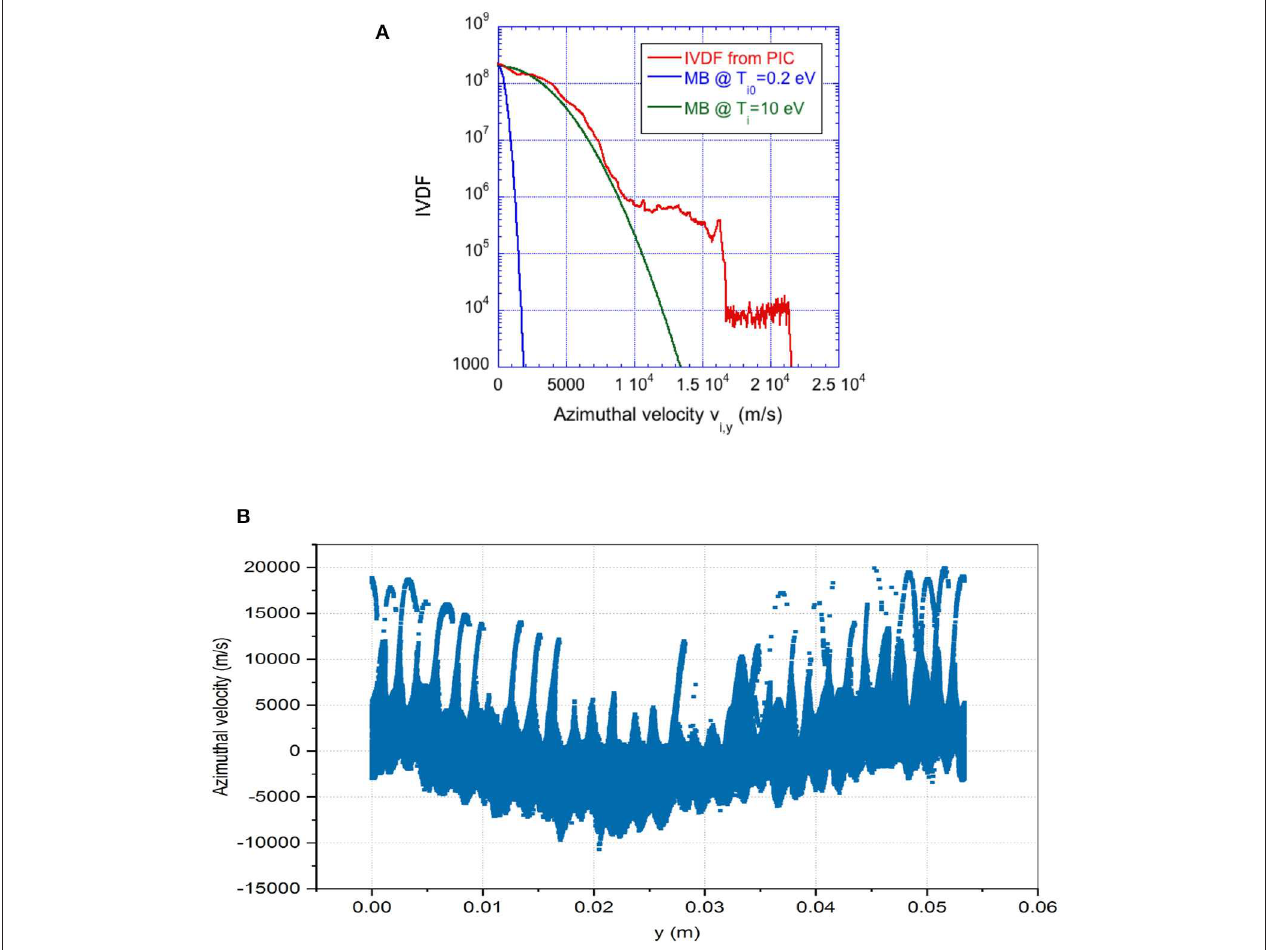
FIGURE 9 | (A) Distribution function of ions and (B) corresponding ion phase space at t 12 µ s (red curve). The Maxwell distribution functions given as reference = have the initial temperature set in the model T i0 0.2eV (blue curve) and the equivalent temperature from best fitting the computed distribution (green =